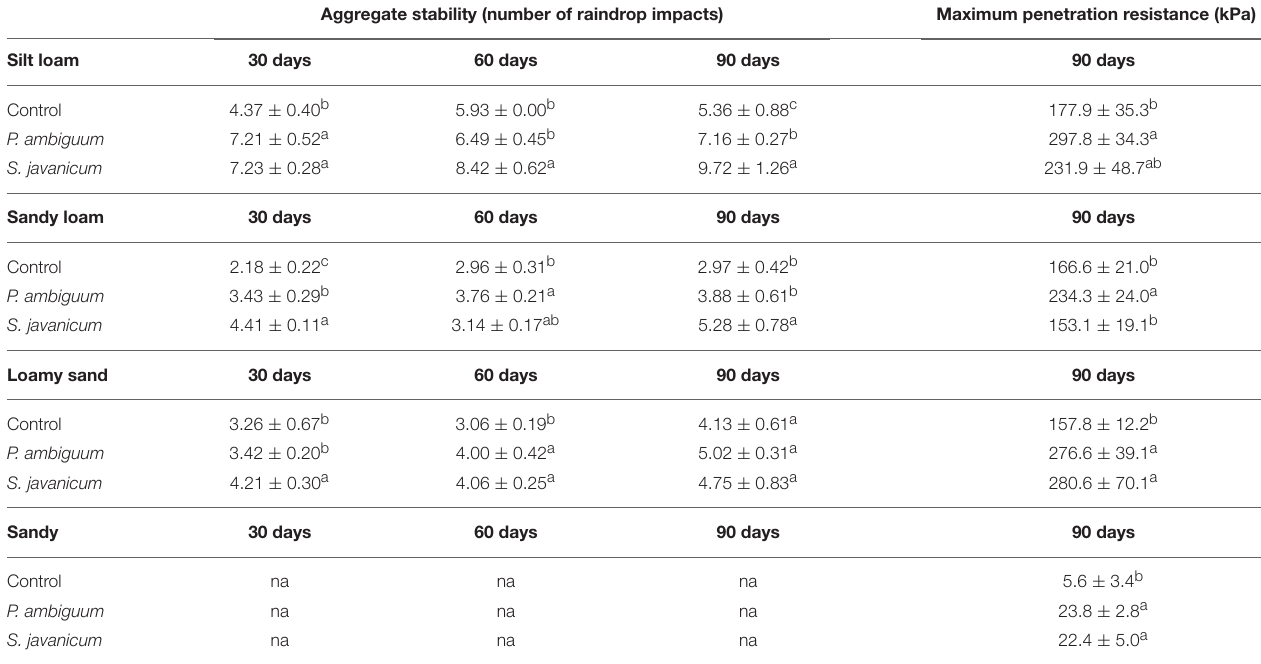
TABLE 5 | Aggregate stability and maximum penetration resistance (mean ± sd) in inoculated and control soils. Aggregate stability (number of raindrop